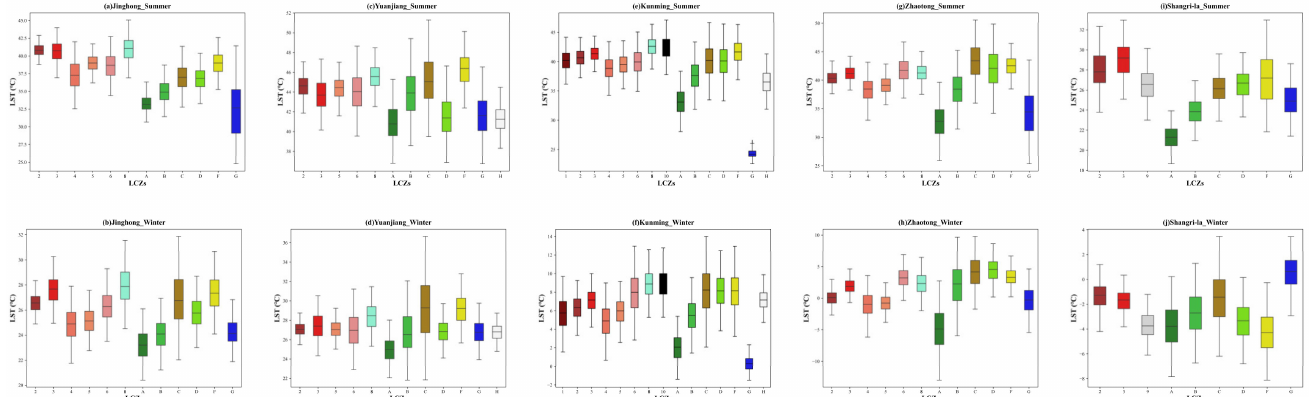
Figure A1. Boxplots of the LST values of the typical LCZs in the different seasons.